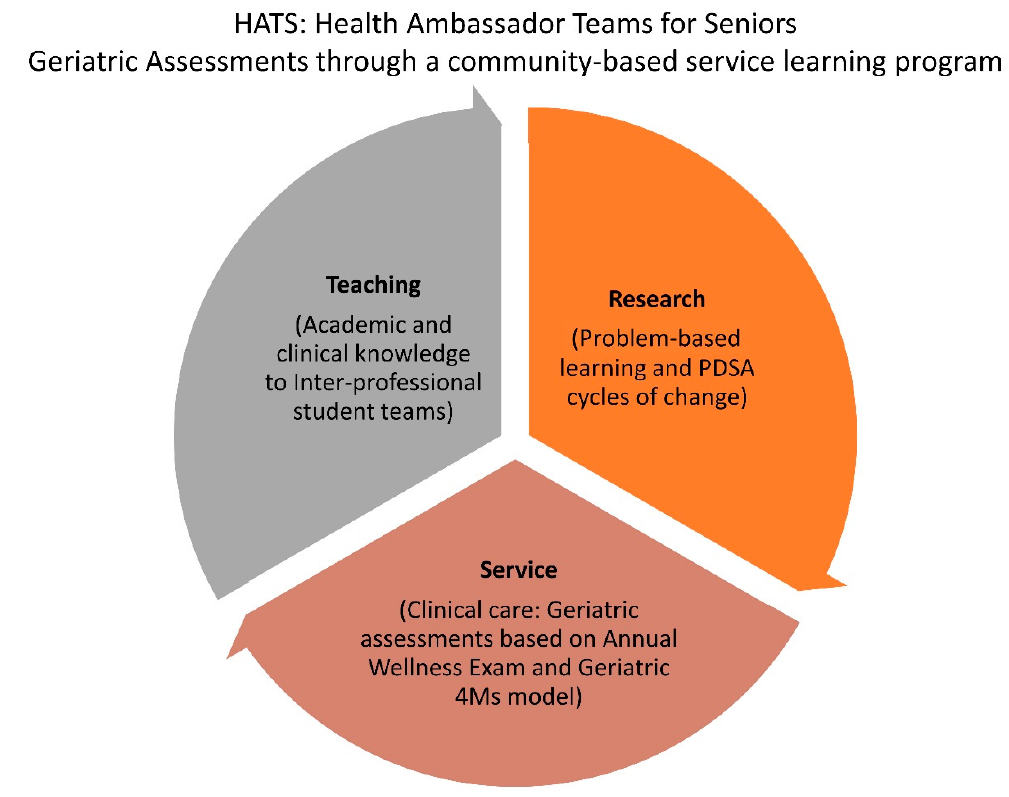
Figure 2. Relationship of HATS program to teaching, scholarly works and community service [46].